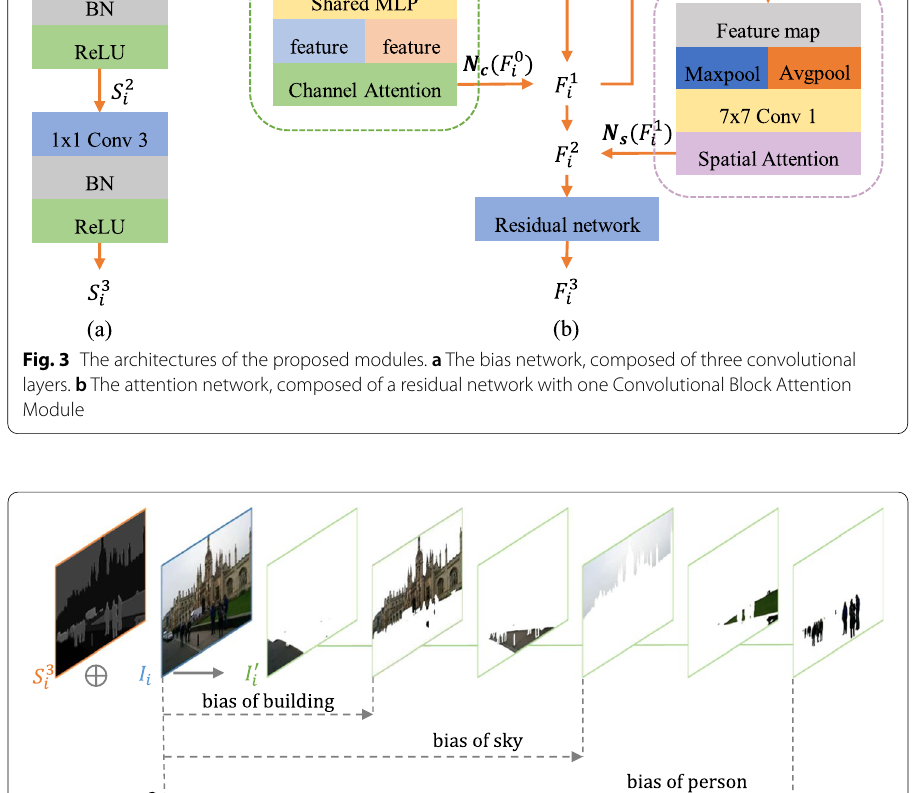
Fig. 4 Element-wise addition of I i and S 3 i . Various bias values are added to different categories. Note that I